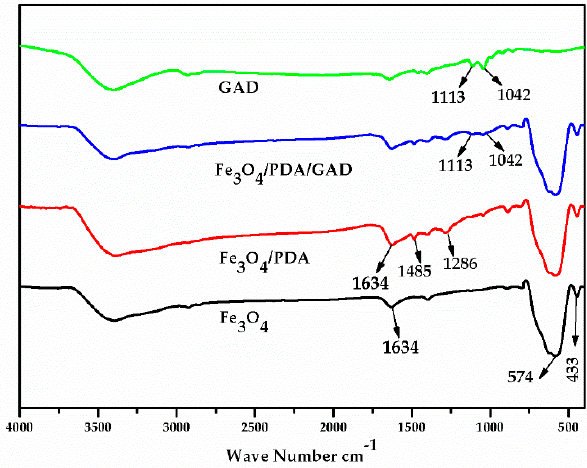
Figure 4. FT-IR transmittance spectrum of Fe 3 O 4 , Fe 3 O 4 /PDA, Fe 3 O 4 /PDA/GAD, and GAD.